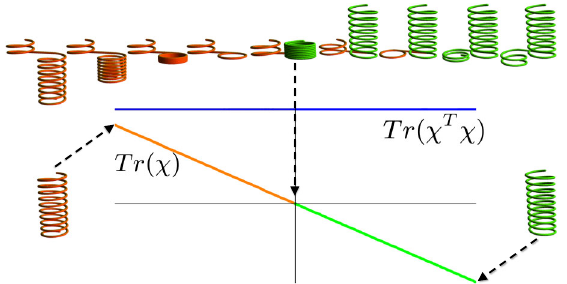
and its left-handed mirror image. The first two isotropic invar- iants of the handedness tensor [calculated explicitly for the curve R þ (cid:8)t Þ ds derived in Sec. III C) ð (cid:7)t t b using the formula X ¼ i j i j plotted against a parameter describing the continuous deforma- tion of the right-handed helix (orange) to the left-handed helix given by the green and (green). The first isotropic invariant (cid:1) ii orange line coincides with the scalar definition of chirality indices. This measure reads zero when the right-handed portion of the helix and the left-handed portion are the same height. However, this configuration is not symmetric under reflections, as the right-handed portion is composed of two windings, whereas the left-handed portion is composed of eight windings. (cid:1) (divided by 10 for graphical pur- The second invariant, (cid:1) ij ij poses), is plotted in blue and barely changes throughout the transformation. In particular, it remains bound away from